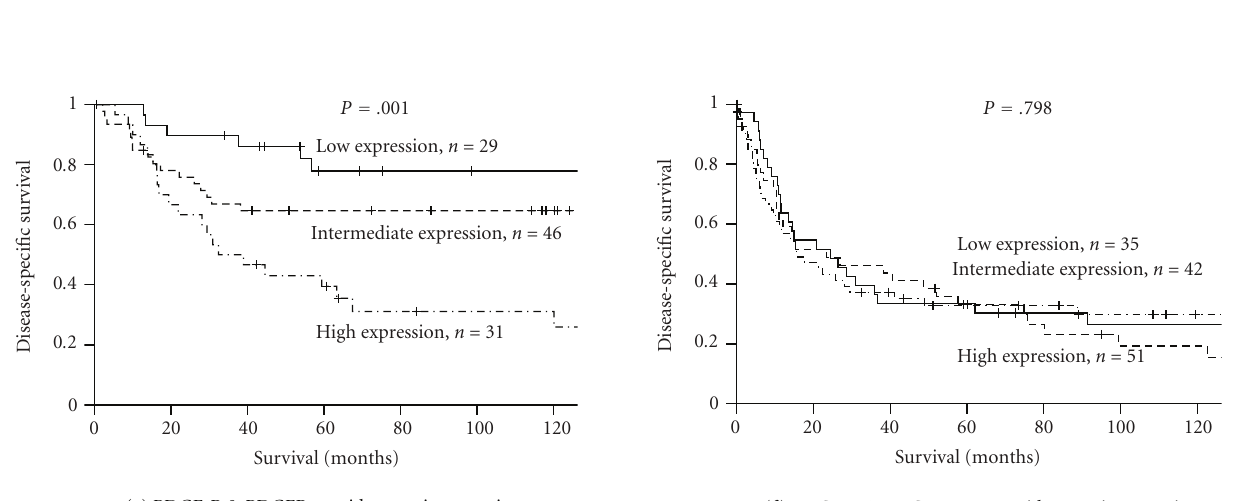
Figure 2: Disease-specific survival curves for PDGF-B and the coexpression of PDGF-B & PDGFR- α in the overall material and in patients with wide and nonwide resection margins. (a) PDGF-B, total material; (b) PDGF-B, wide resection margins; (c) PDGF-B, nonwide resection margins; (d) coexpression of PDGF-B and PDGFR- α , total material; (e) coexpression of PDGF-B and PDGFR- α , wide resection margins; (f) coexpression of PDGF-B and PDGFR- α , nonwide resection margins. Abbreviations: PDGF: platelet-derived growth factor; PDGFR: platelet-derived growth factor